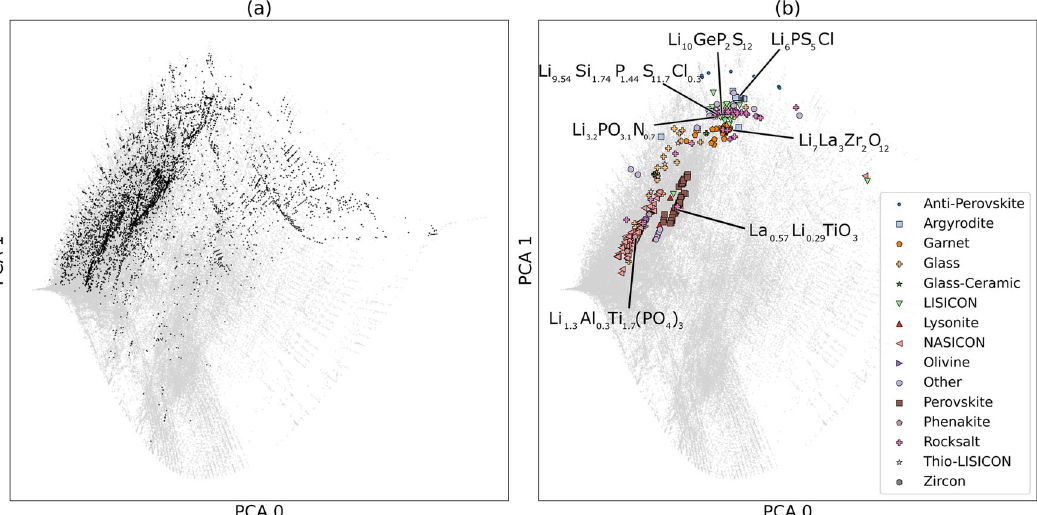
Fig. 3 An embedding of the 127,638 unique compositions (grey) from the ICSD database (2021) with respect to ElMD similarity between compounds, embedded to 2 principle axes with PCA. a 6972 of these compositions contain lithium (black), and b 455 unique compositions from this dataset with an experimentally measured conductivity at any temperature. The expert-curated structural label that each composition belongs to is indicated by the colour scheme given in the legend, with a selection of representative compositions and their embedded coordinates